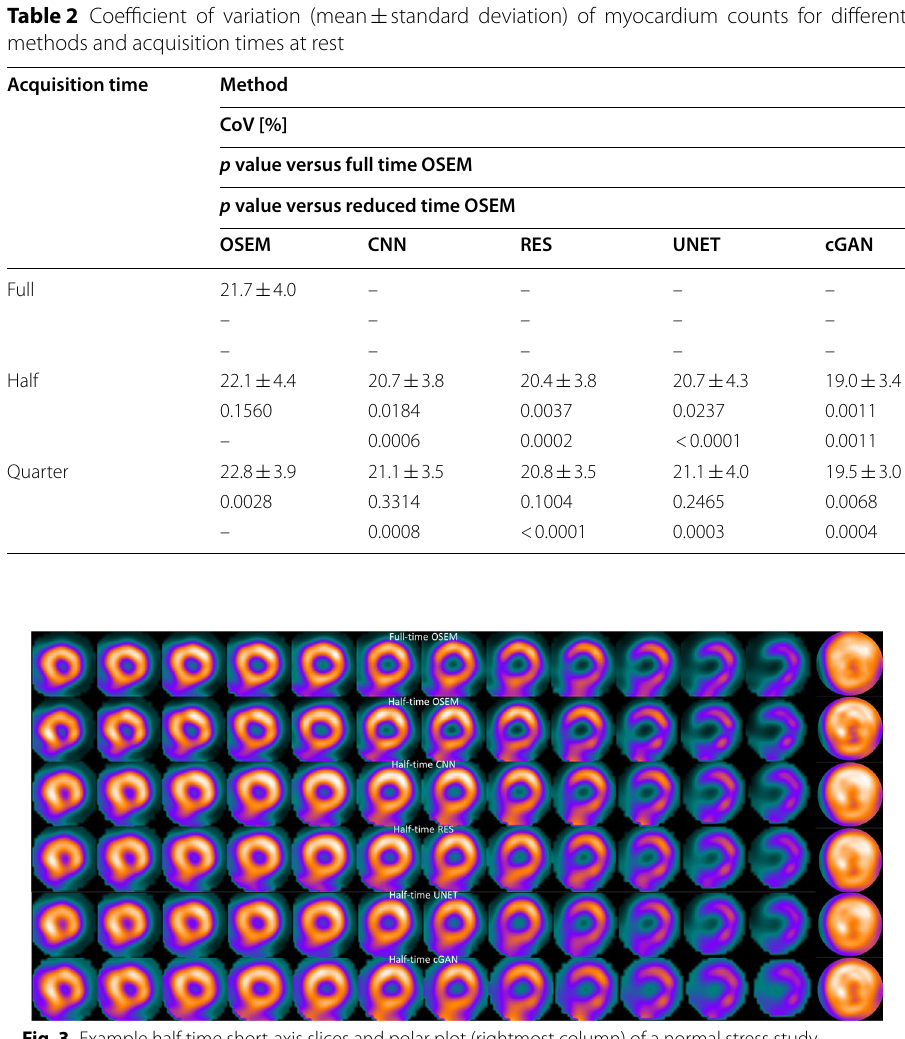
Fig. 3 Example half time short-axis slices and polar plot (rightmost column) of a normal stress